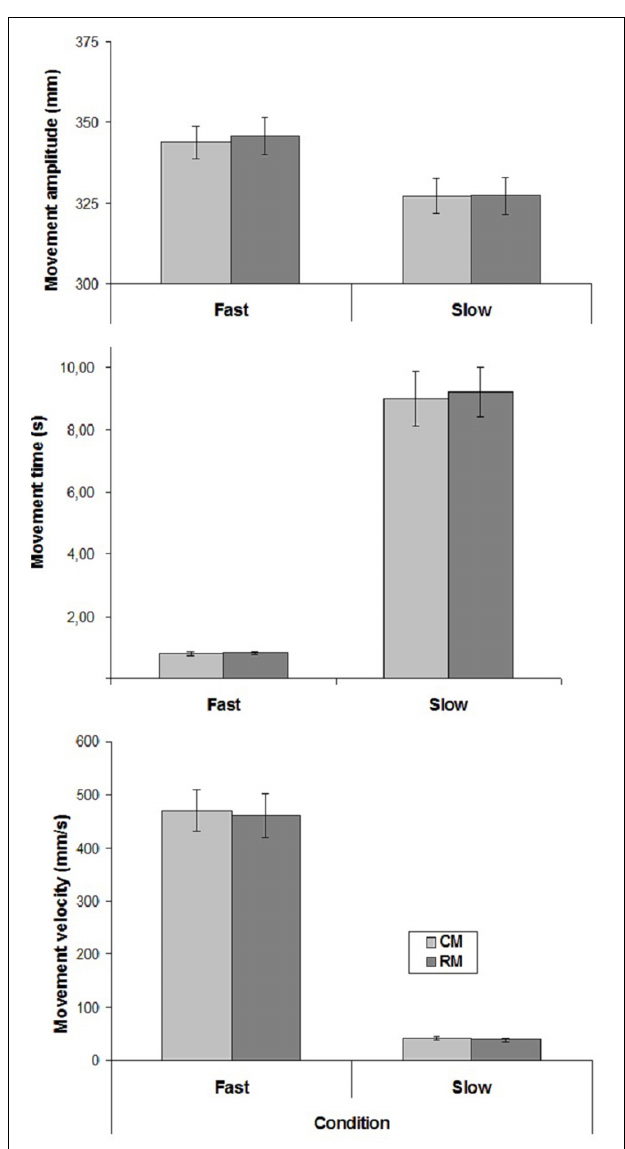
FIGURE 2 | Mean values of movement amplitude and mean velocity in the two experimental conditions of Experiment 2. Mean values are shown with SE ( bars ). CM, criterion movement; RM, reproduction